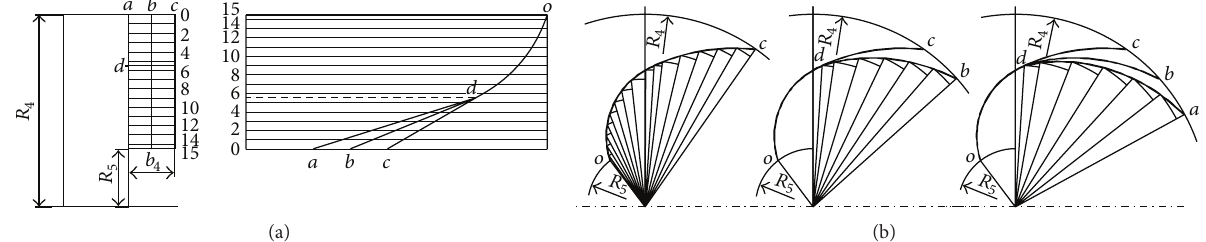
Figure 6: Blade profile drawing procedure: (a) blade angle distribution profiles and (b) blade profiles.